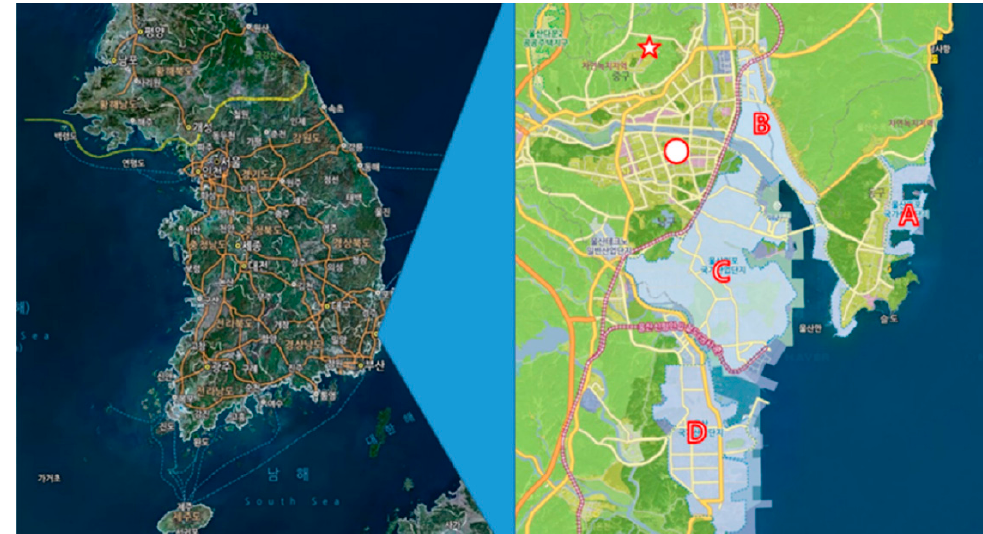
Figure 1. Location of the intensive air quality monitoring station ( ✩ ) in the southeastern region of Korea (A, B, C: Ulsan Mipo National Industrial Complex (A: Shipbuilding industries in high proportions, B: automobile manufacturing in high proportions, C: nonferrous industry and petrochemical industry in high proportions), D: Onsan National Industrial Complex (nonferrous industry and petrochemical industry in high proportions), and ○ : Ulsan Downtown).